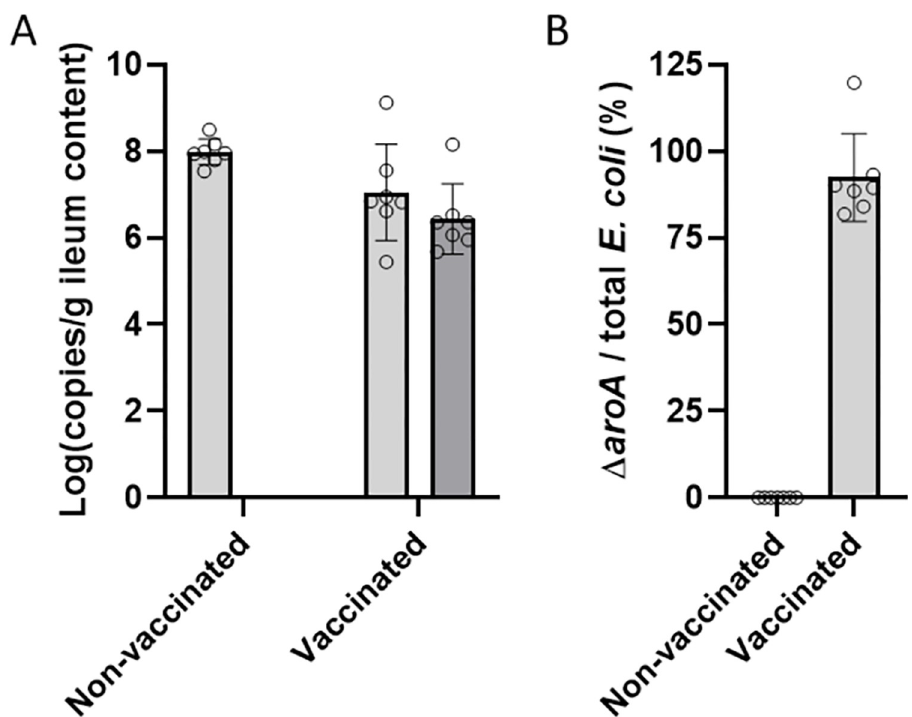
Fig 4. Detection of Δ aroA vaccine-strain and total E . coli load in ileal samples of vaccinated (n = 7) or non- vaccinated birds (n = 7). Birds from the vaccinated group received 10 8 CFU Δ aroA vaccine per bird at day of hatch. At 3 days of age (2 days after vaccination), ileal content was collected. (A) Simultaneous detection of the vaccine strain (targeting the mutant aroA gene) (dark grey bars) and total E . coli load (targeting the xanQ gene) (light grey bars) was obtained using the duplex qPCR. Total E . coli load in the ileum of vaccinated birds tended to be lower than in non- vaccinated birds (p = 0.053). (B) 92.4% of the total E . coli load in the vaccinated birds was attributed to the Δ aroA vaccine strain, whereas in the non-vaccinated birds, no vaccine strain was